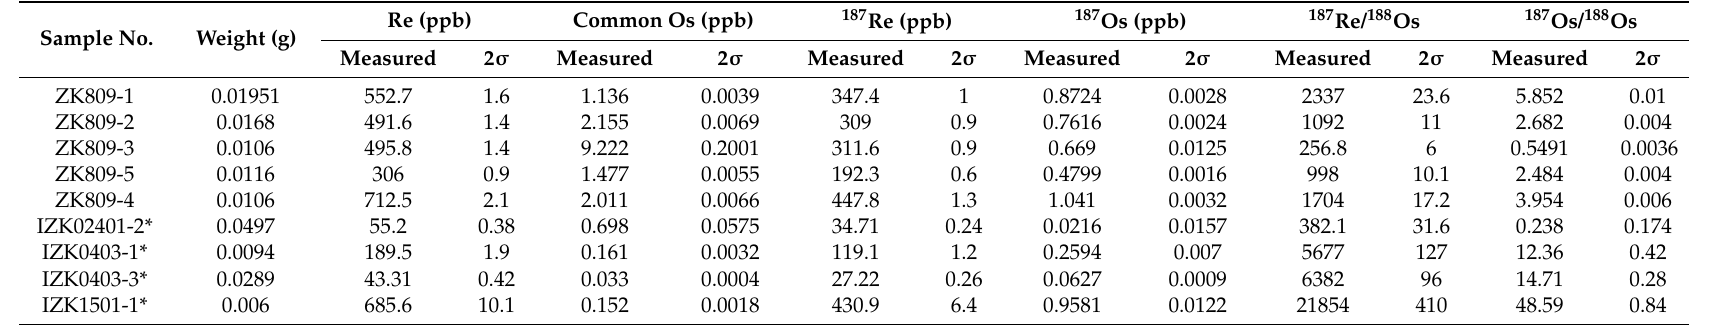
Table 2. Results of Re-Os isotopic analyses of greisen stage from the Weilasituo Sn-polymetallic